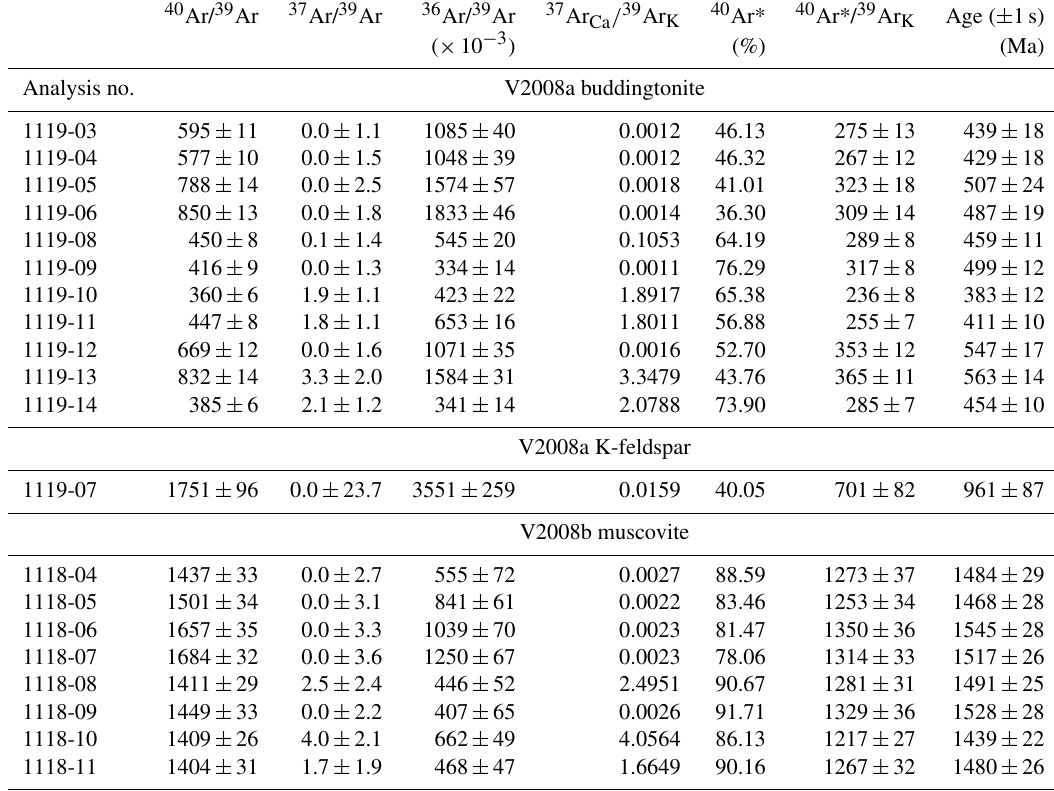
Table 1. Results of Ar isotopic ratios’ measurements. 40 Ar/ 39 Ar Analysis no. V2008a